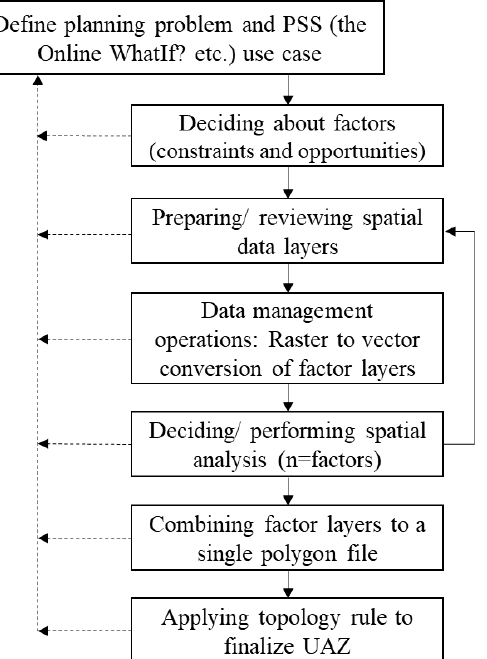
Figure 4. Standard practice workflow of an Online WhatIf? user to generate UAZ.